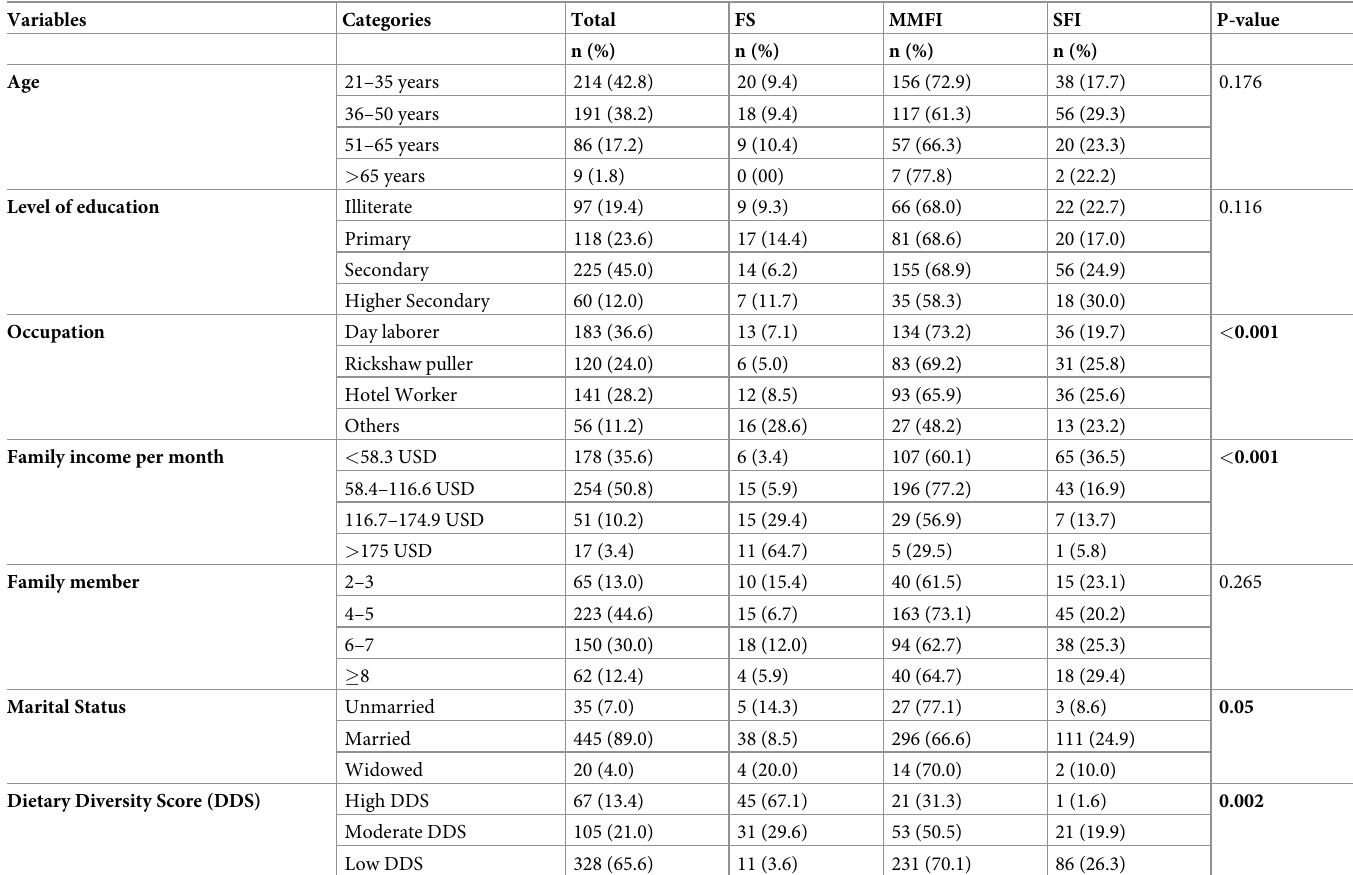
Table 1. Characteristics of respondents based on household food insecurity access proportion (n =